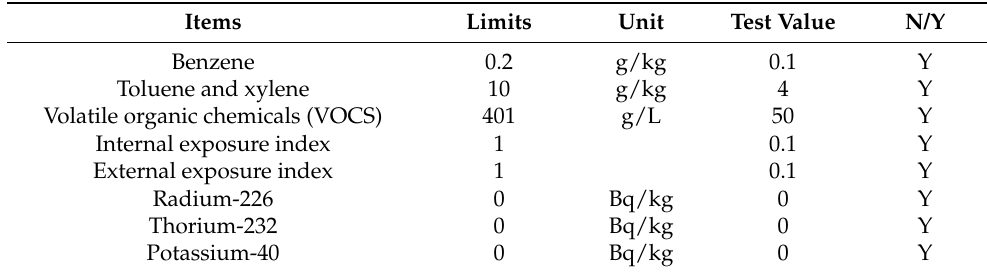
Table 8. Toxic test results of the XG–6001 acrylate